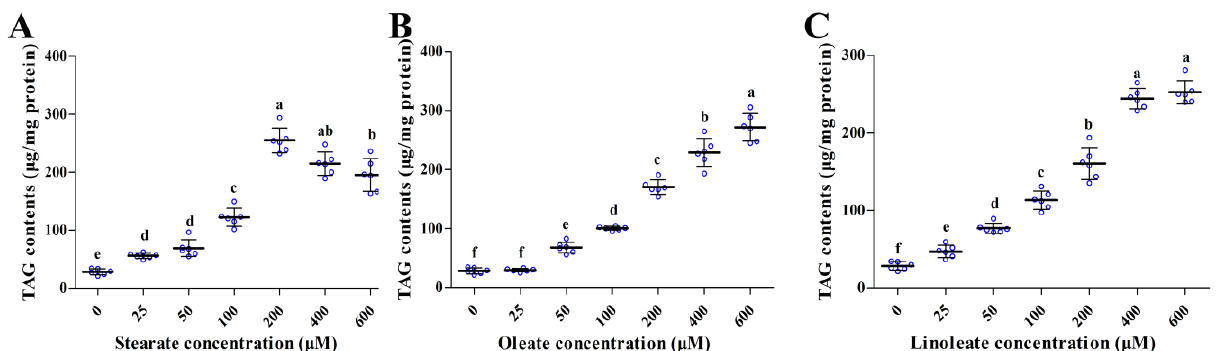
Figure 2. Effect of stearate, oleate and linoleate on cellular TAG content in pMECs. pMEC cells were incubated with 0 (control), 25, 50, 100, 200, 400 and 600 μM stearate ( A ), oleate ( B ) or linoleate ( C ), respectively, for 24 h. The data are expressed as the mean ± SD ( n = 6, blue dots display the number of measurements). Comparisons between groups were performed via ANOVA and Tukey’s range test for multiple comparisons. Different letters indicate statistical significance between different concentrations of stearate, oleate and linoleate treatment groups ( p < 0.05).